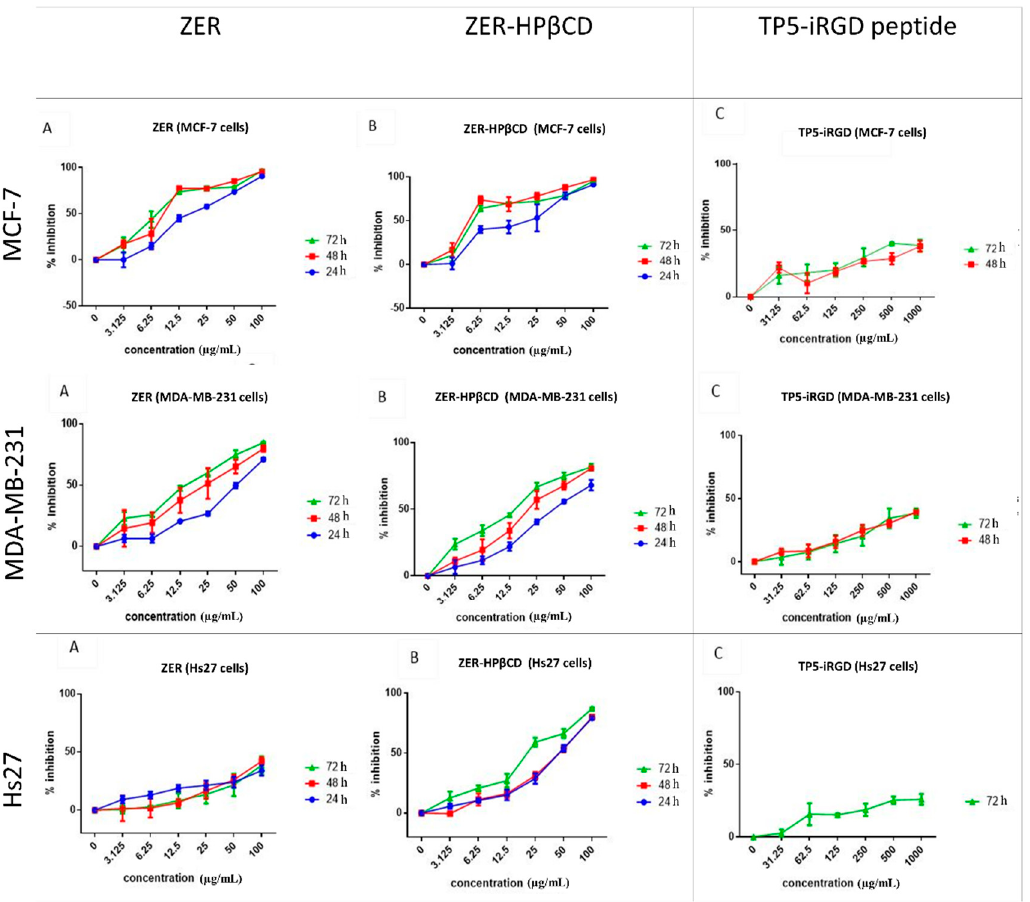
Figure 2. Percentage of cell inhibition (3-(4,5-dimethylthiazol-2-yl)-2,5-diphenyltetrazolium bromide(MTT) assay) of MCF-7, MDA-MB-231, and Hs27 cells treated with zerumbone (ZER) ( A ), ZER-hydroxypropyl- β -cyclodextrin(HP β CD) ( B ), and TP5-iRGD peptide ( C ). Table 1. Inhibitory concentration (IC) 50 of zerumbone (ZER), ZER-hydroxypropyl- β - cyclodextrin(HP β CD) and TP5-iRGD peptide. Cell ZER ZER-HP β CD TP5-iRGD Peptide Lines